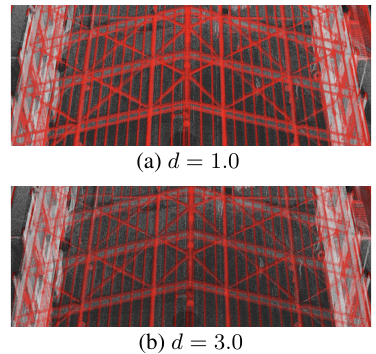
Figure 11. Effect of the parameter d in formula